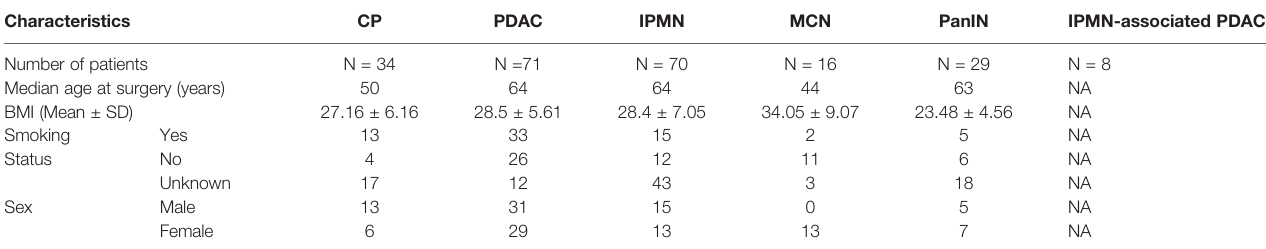
TABLE 1 | A summary of clinical characteristics of the patient cohort.